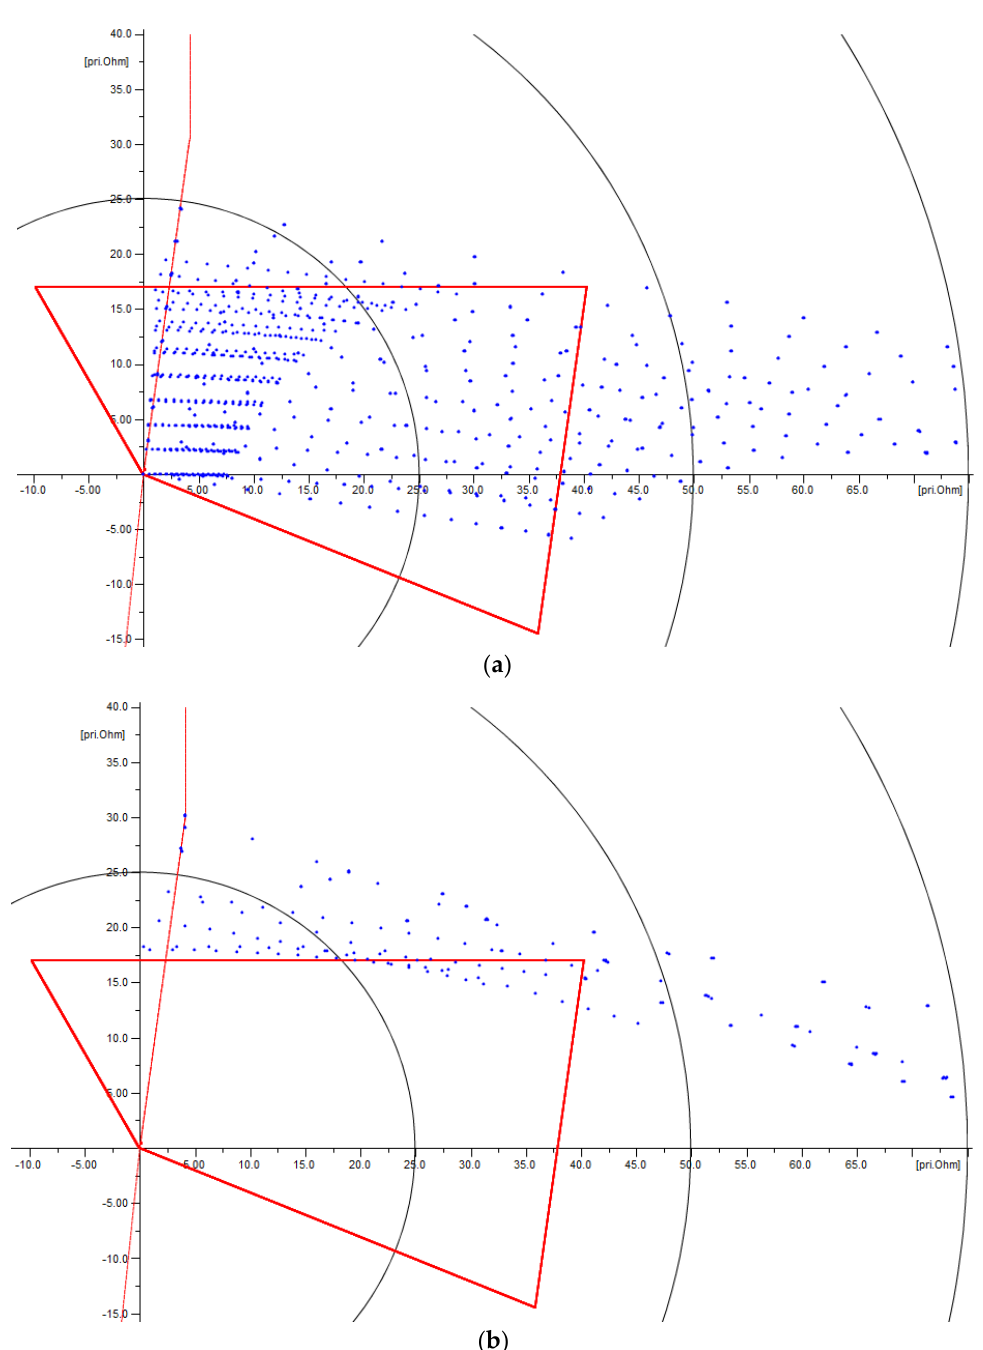
Figure 13. Calculated Zone 1 settings and measured loops for faults grouped in ( a ) set D 1 for Zone 1 calculation, and ( b ) set F 1 for Zone 1 calculation.